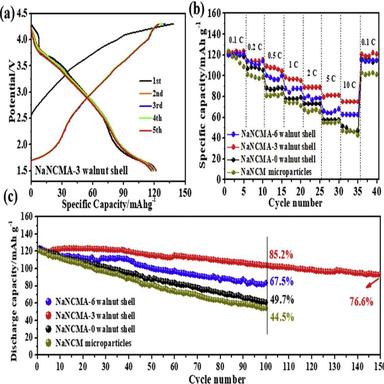
CV curves at a scan rate of 0.1 mV s1 for (a) the walnut-shell-like NaNCMA-0, (b) NaNCMA-3 and (c) NaNCMA-6 samples. (d) Nyquist plots of the walnut-shell-like NaNCMA-0, NaNCMA-3 and NaNCMA-6 samples.